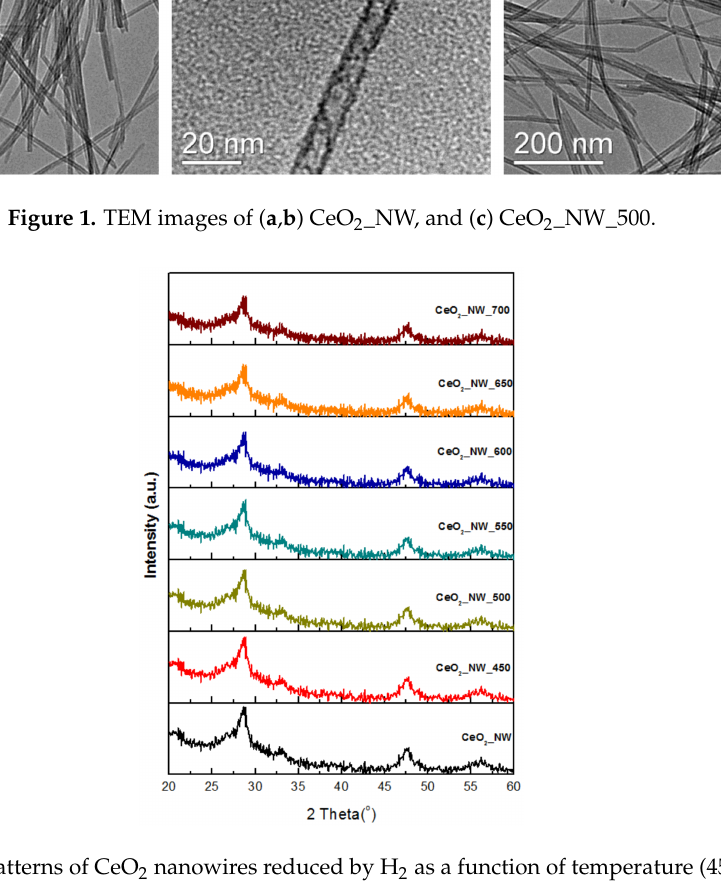
Table 1. For CeO 2 _NW_450 and CeO 2 _NW_500, more plentiful moderately acidic and alkaline sites